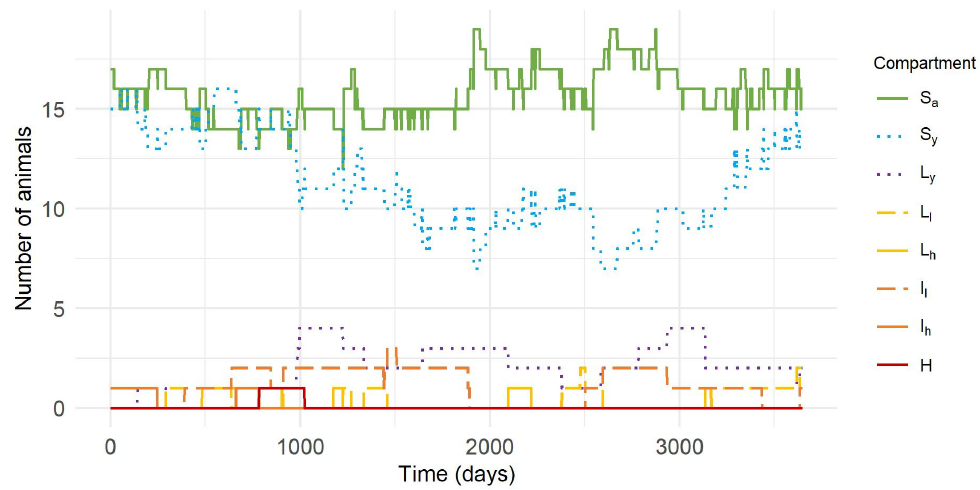
Figure 2. Demonstration of an iteration of the model simulations for the spread of Mycobacterium avium subsp. paratuberculosis in a typical Slovenian dairy herd. Susceptible cows (S a ); susceptible young (S y ); latent young (L y ); latent cows on low shedding pathway (L l ); latent cows on high shedding pathway (L h ); infected cows on low shedding pathway (I l ); infected cows on high shedding pathway (I h ); high shedders (H).